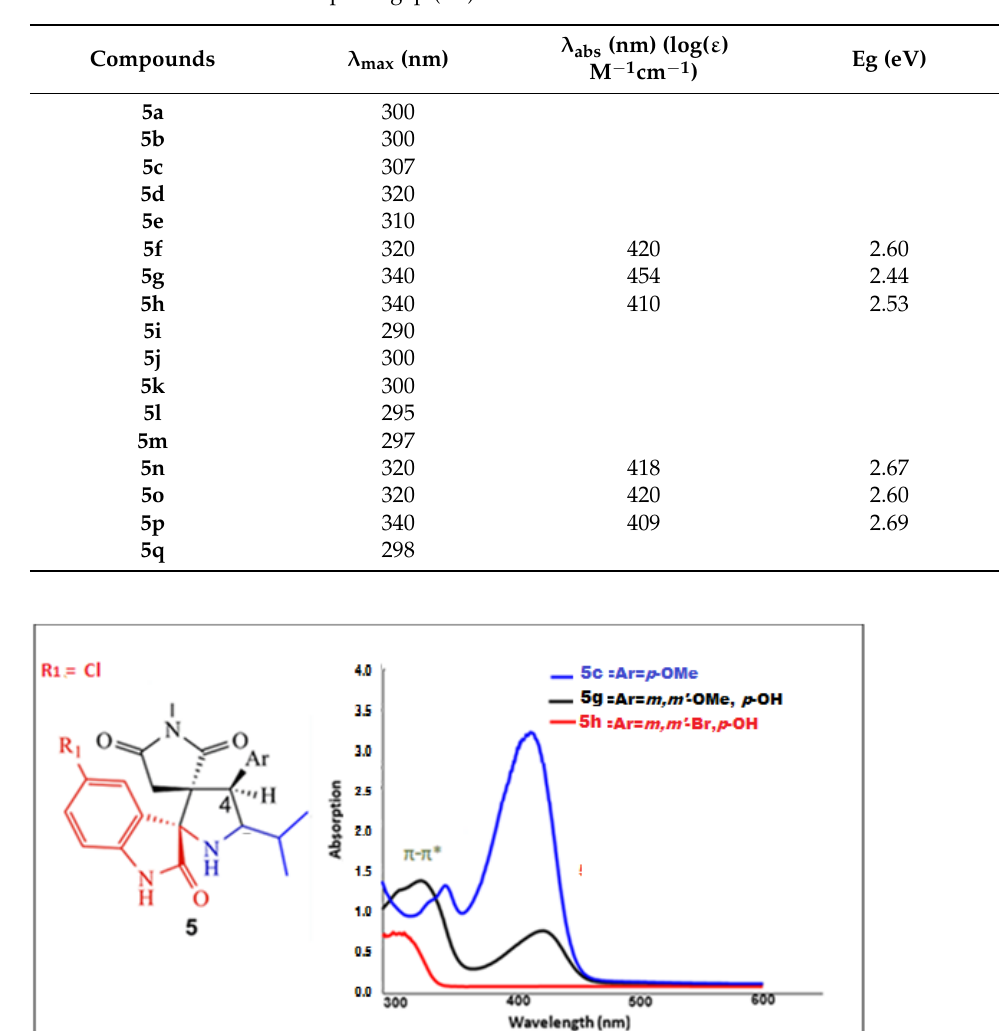
Table 3. UV-vis maxima and optical gap (eV) for series 5 .